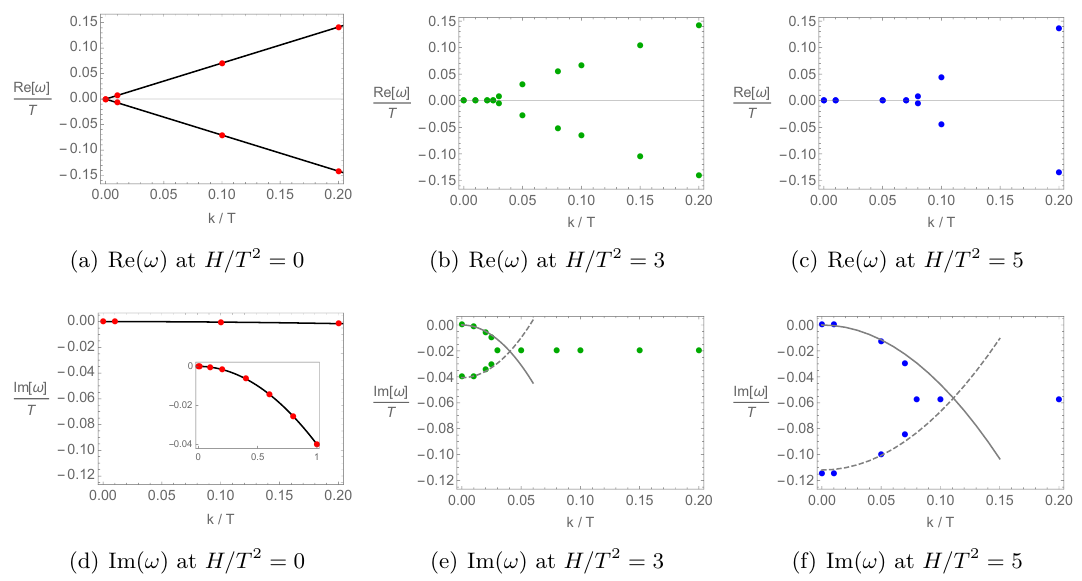
Figure 6 . Quasi-normal modes vs the magneto-hydrodynamic prediction of the dispersion relations. Left: (a) and (d) are QNMs at H/T 2 = 0 . Center: (b) and (e) are QNMs at H/T 2 = 3 . Right: (c) and (f) are QNMs at H/T 2 = 5 . All figures: colored dots are numerically computed quasi- normal modes and the black solid line is (4.12), the gray solid line is (4.13), and the gray dashed line is